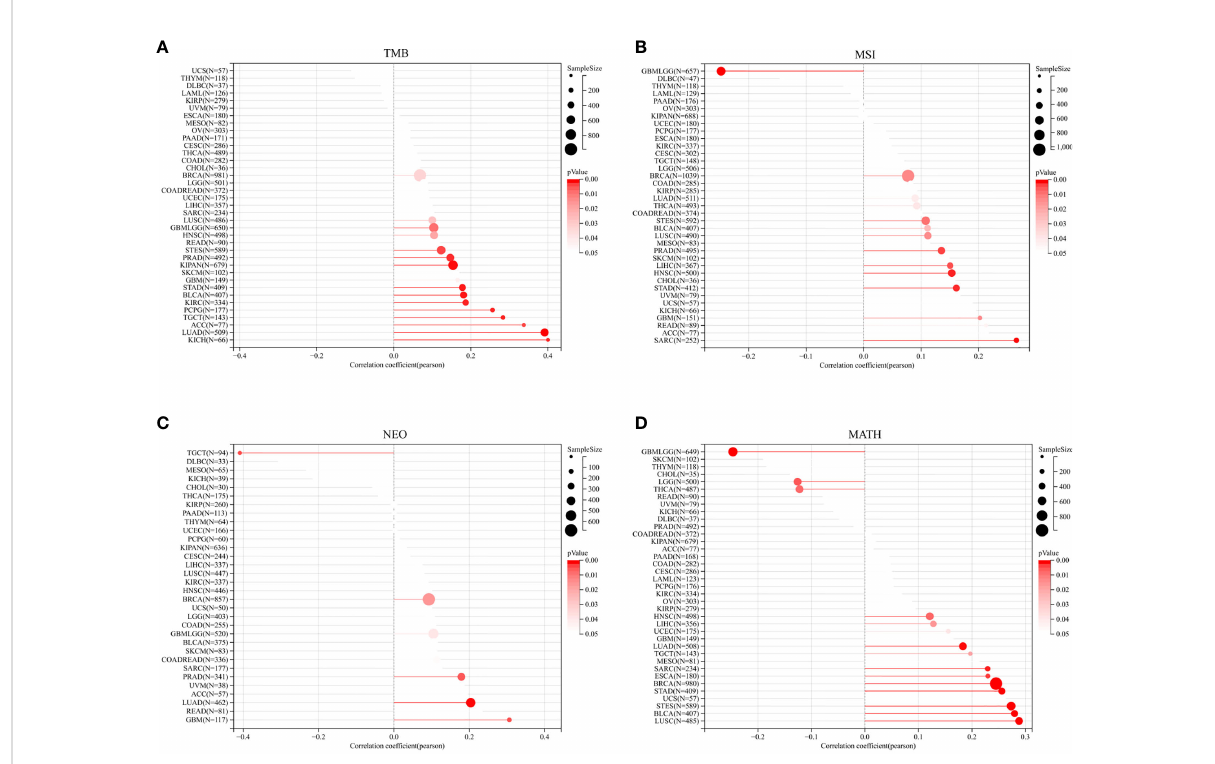
FIGURE 8 The relationship between the transcriptional level of TROAP and the genetic mutation in pan-cancer. (A) tumor mutational burden (TMB). (B) microsatellite instability (MSI). (C) neoantigen (NEO). (D) mutant-allele tumor heterogeneity